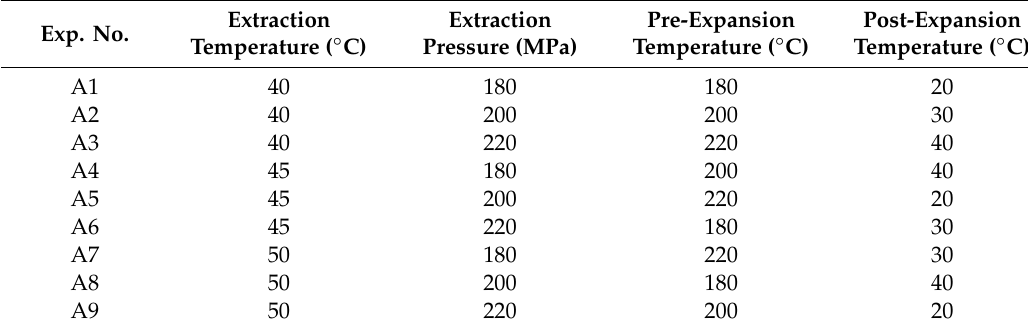
Table 2. The L 9 (3 4 ) orthogonal array of the Taguchi experiments.